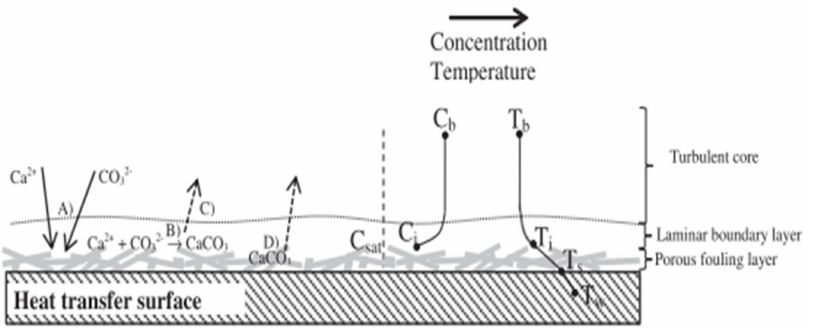
Figure 17. Illustration of the crystallization fouling mechanisms and the concentration and tempera- ture profiles in the